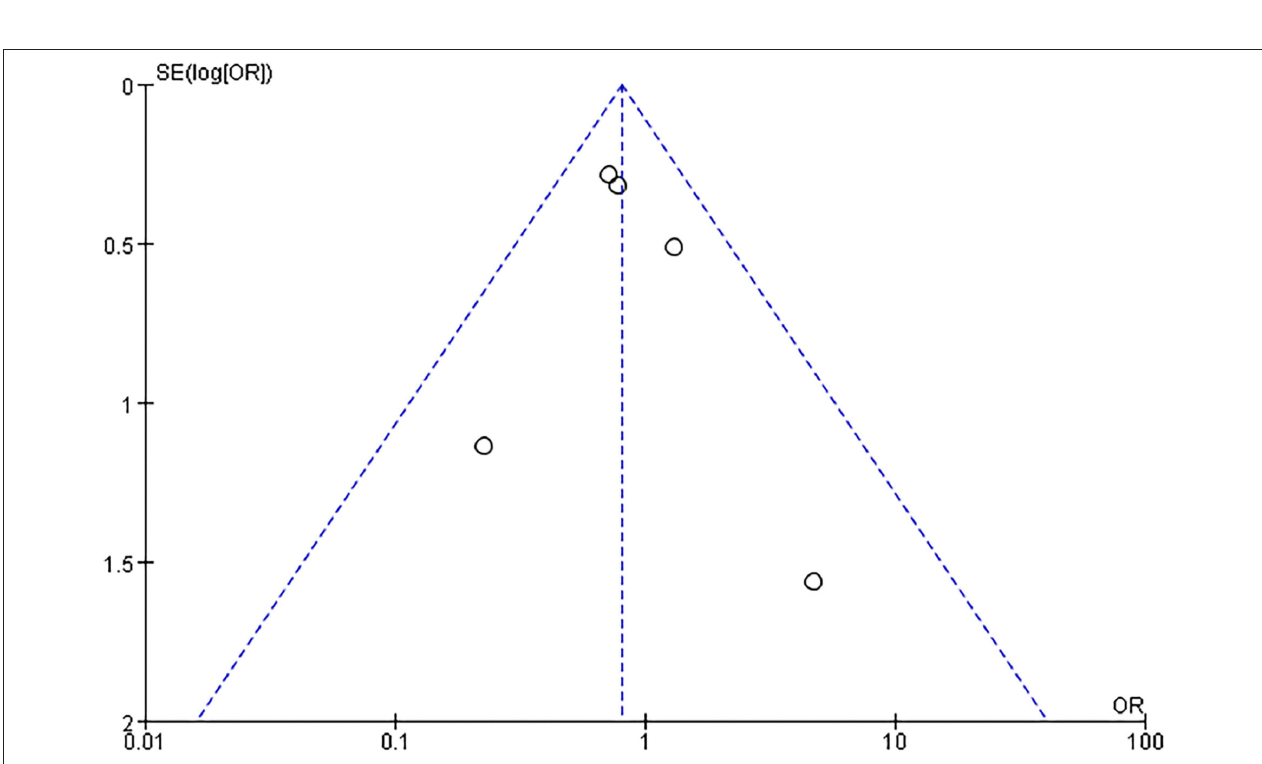
FIGURE 11 | Funnel plot of comparison: ESD care vs. usual care, outcome: death.